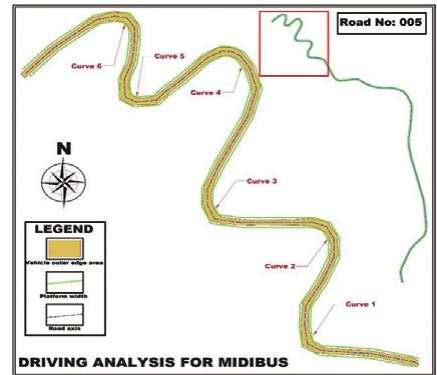
Fig. 6. Results of horizontal driving analysis for midibus